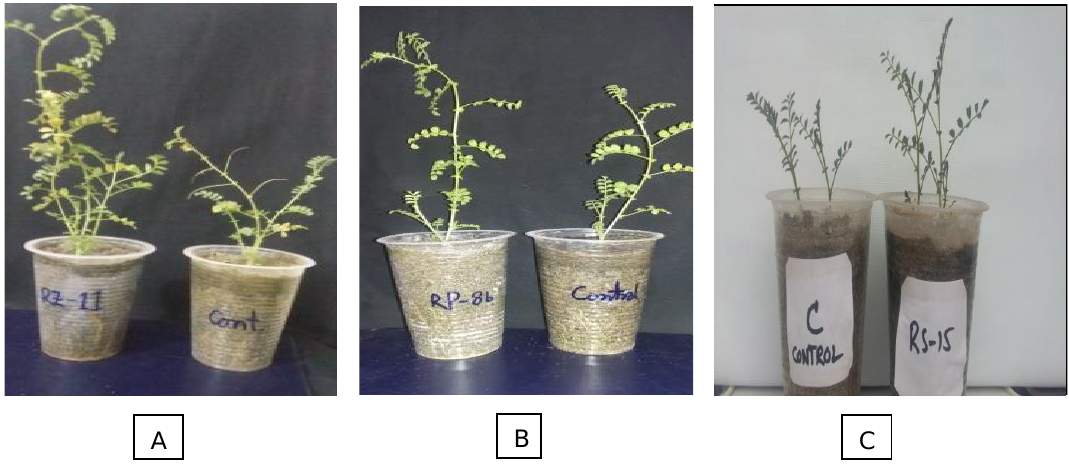
Figure 3. Effect of strains on chickpea shoot length in growth chamber, where ( A ) Mesorhizobium ciceri -